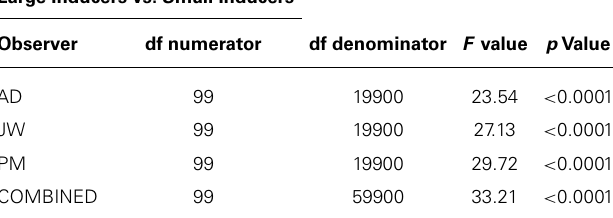
Table 2 | Degrees of freedom, F values and p values obtained from the independent two-sample Hotelling T 2 statistic, testing for the difference between the radial classification images obtained for each human observer and the combined data across observers with Large and Small